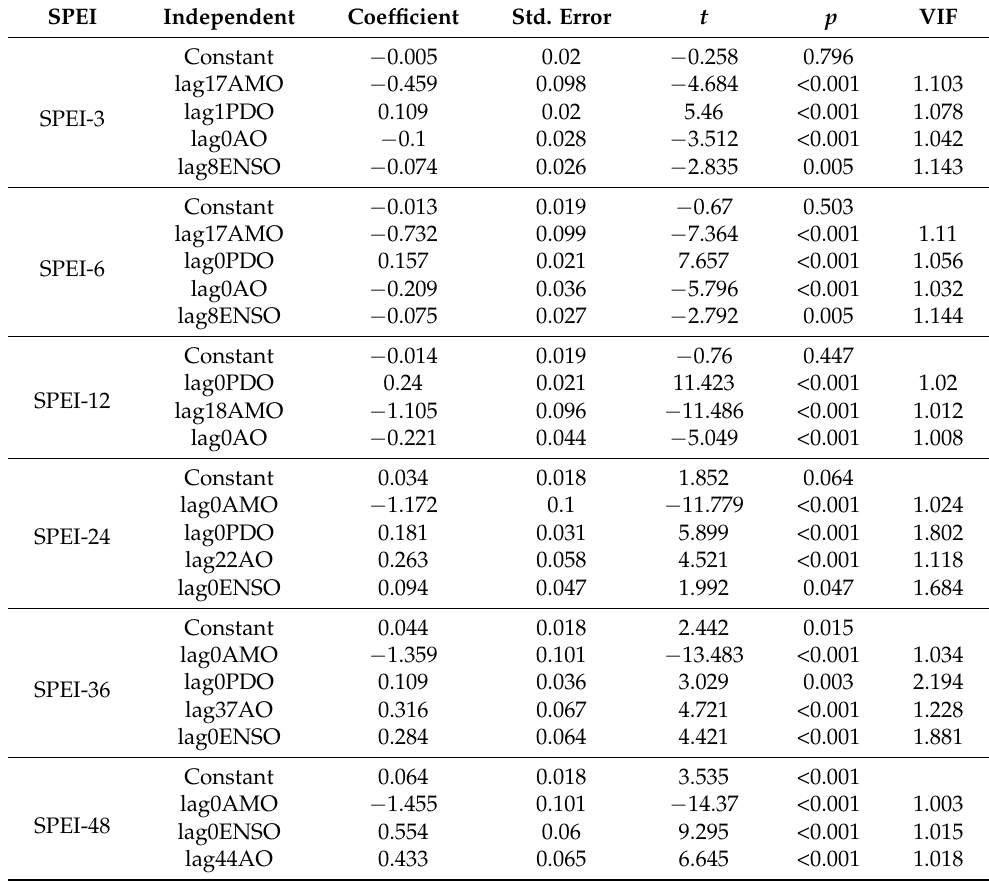
Table 2. Test statistics of stepwise regression for SPEI-3, SPEI-6, SPEI-12, SPEI-24, SPEI-36, and SPEI-48 based on the optimal time-delay ENSO, PDO, AMO, and AO indices series. Lag k indicates that SPEI lags teleconnections by k months, hence lag 0 denotes the series of factors synchronized with SPEI. The significance of the t -test statistics is evaluated at 95% confidence interval. Two-tailed t -test statistics is applied, hence the computed p -value less than 0.025 indicates the significance of relationship between the SPEI and teleconnections. The higher Variance Inflation Factor (VIF) refers to the stronger the multi-collinearity is. SPEI Independent Std. Error